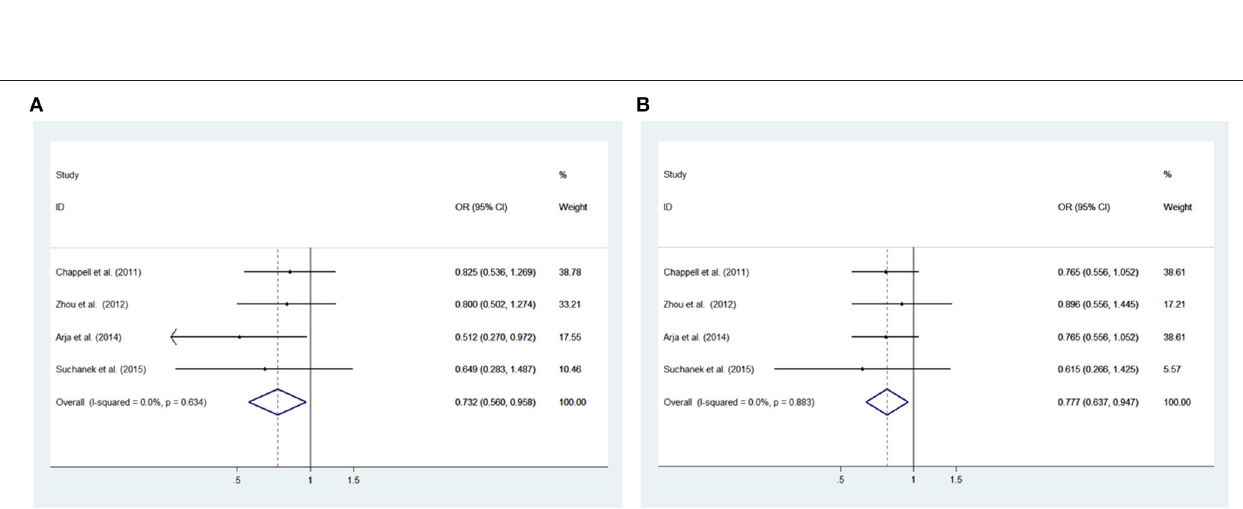
Frontiers in Genetics | www.frontiersin.org